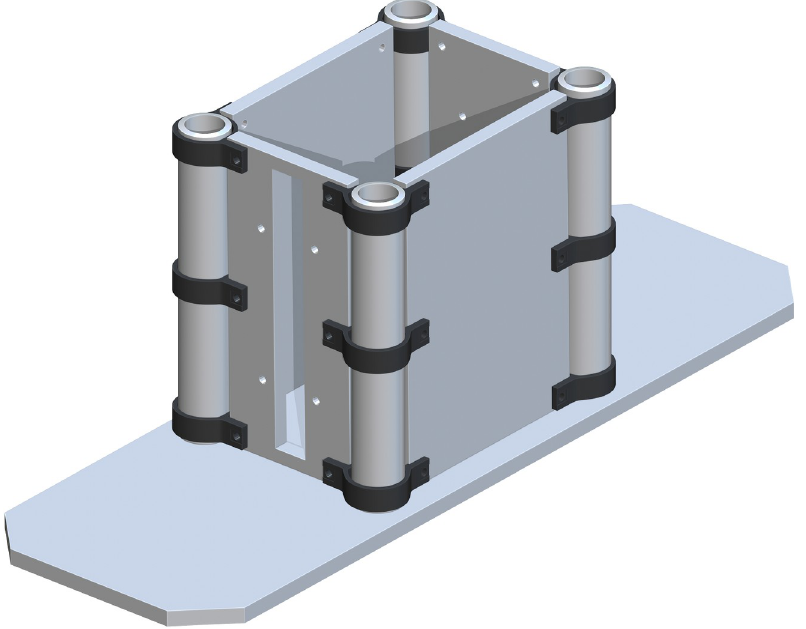
Fig 3. Total 3_INCH_PVC_to_HDPE_Sheets_Outside on each Base 3in Pipe.